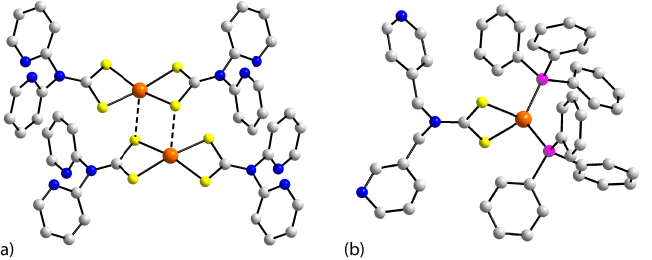
Figure 3. Molecular structures for ( a ) Cu(L 7 ) 2 ( 12 ) (showing supramolecular association via Cu · · · S interactions between centrosymmetrically-related molecules) and ( b ) (Ph 3 P) 2 Cu(L 10 ) ( 15 ).